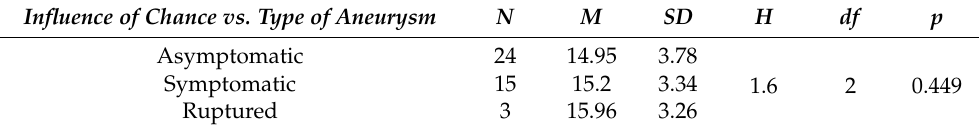
Table 9. Influence of chance vs. age, BMI, and nicotine addiction. Influence of Chance N rHO Age 42 The influence of doctors N Number of cigarettes smoked per day